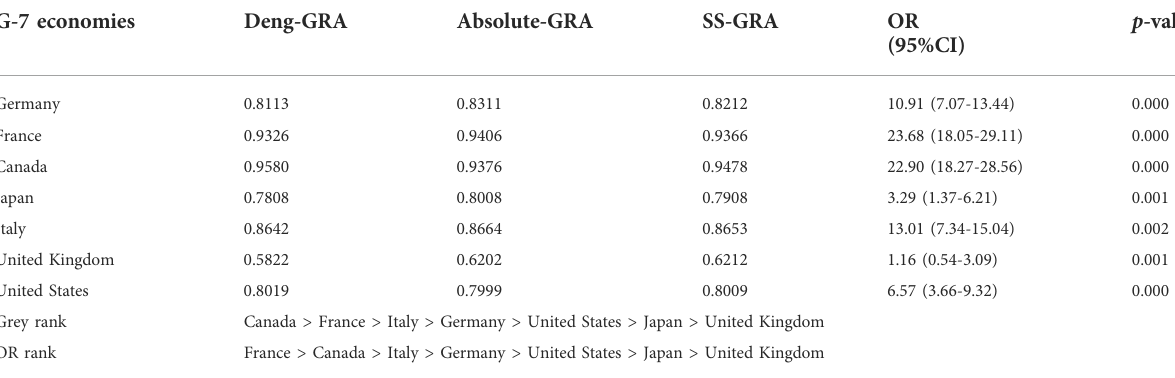
TABLE 5 Mathematical and statistical assessment between carbon emissions and